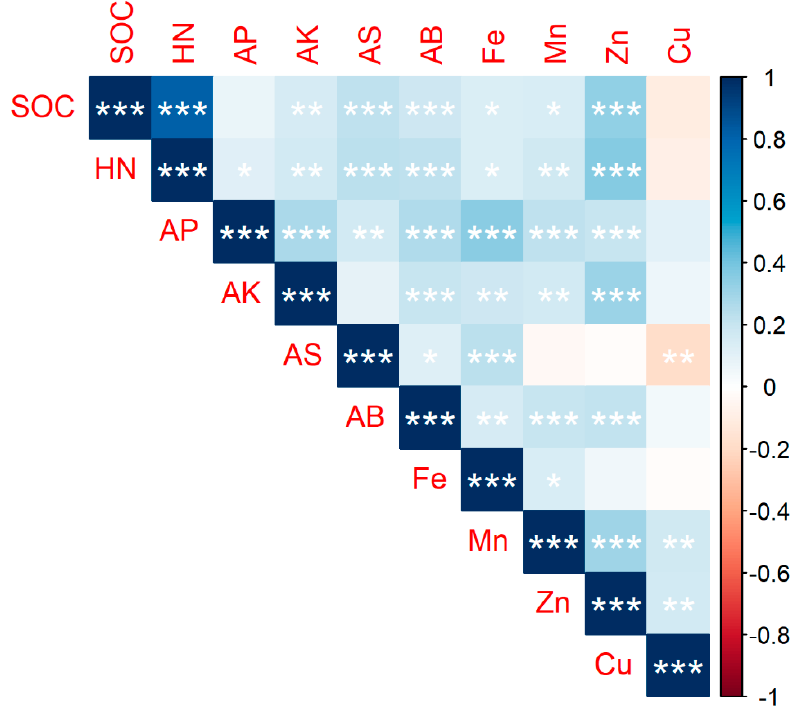
Figure 2. Correlation analysis of soil physicochemical properties in hickory plantations. (SOC indicates soil organic carbon, SK indicates soil available potassium, AP indicates soil available phosphorus, AS indicates available sulfur, HN indicates soil hydrolyzed nitrogen, AB indicates soil available boron. * Correlation is significant at the 0.05 level, ** Correlation is significant at the 0.01 level, *** Correlation is significant at the 0.001